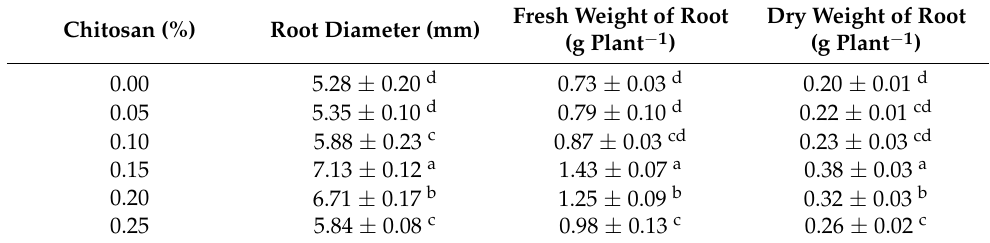
Table 5. Influences of chitosan on diameter, fresh weight, and dry weight of P. grandiflorus roots.